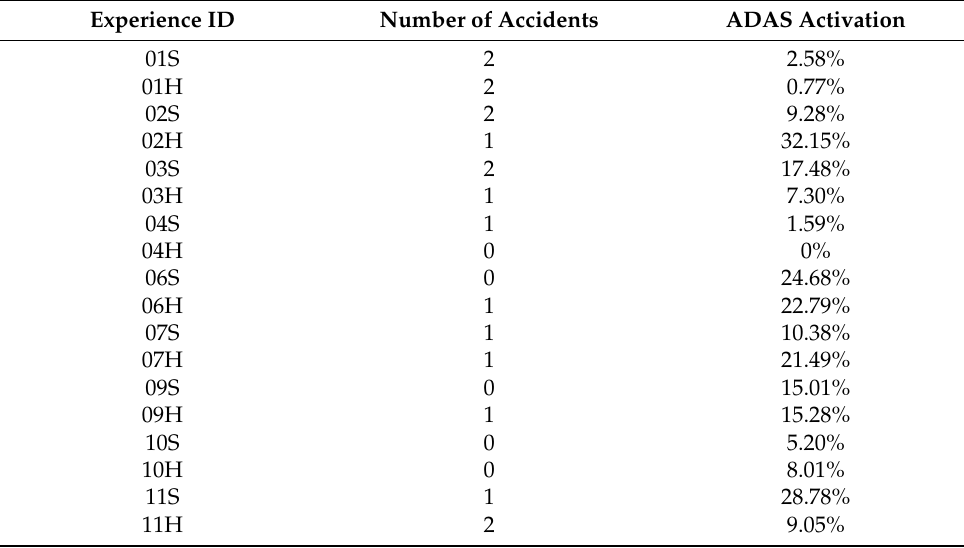
Table 1. Number of accidents and ADAS activation time per driving